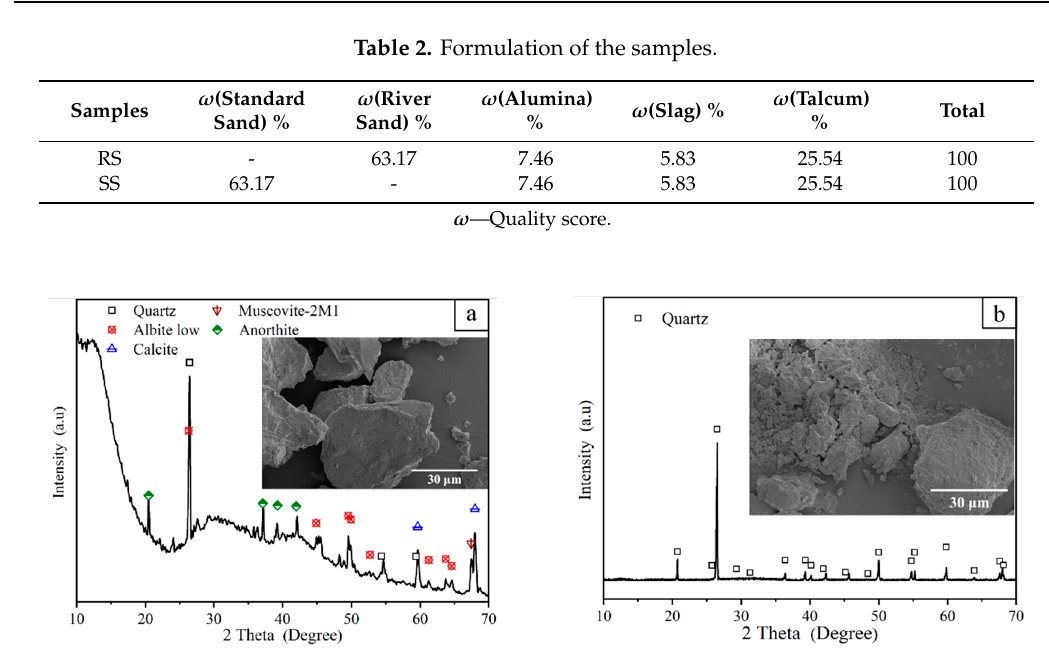
Table 2. Formulation of the samples.